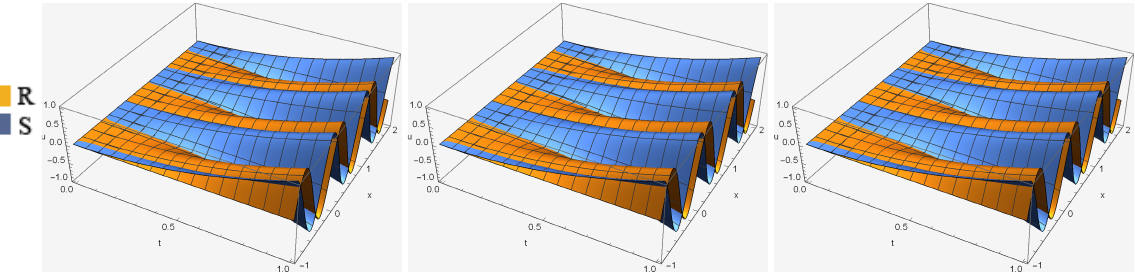
Figure 2. Error graph of R and S in Equation (1) for α = 0.9, α = 0.5, α = 0.1, respectively, τ = 0.002, a = 0, b = 1, N = 40 and t = 1.